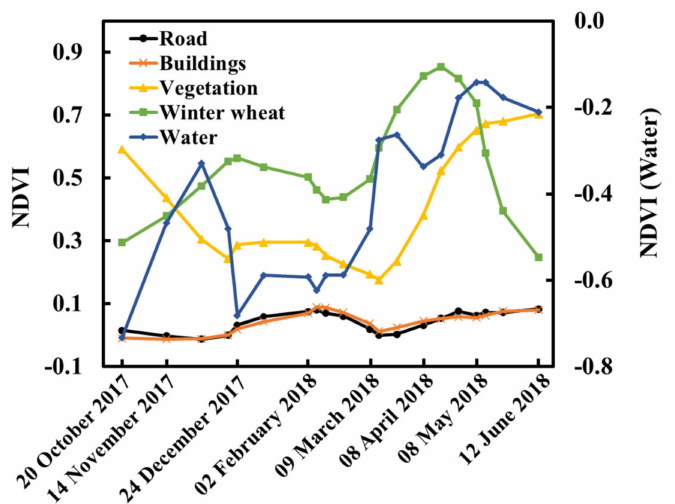
Figure 4. Normalized difference vegetation index (NDVI) time series of different land